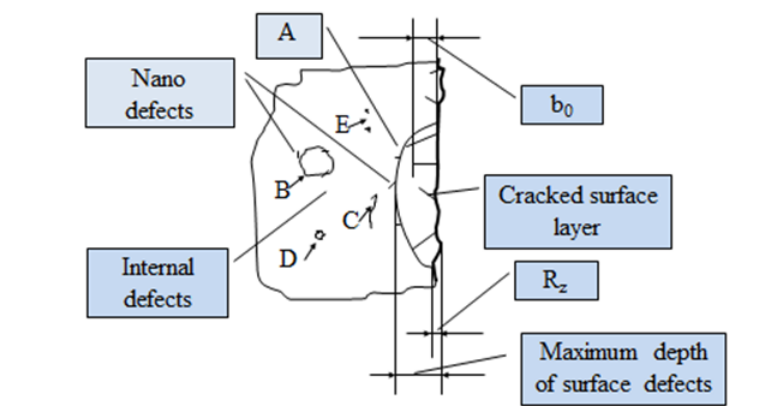
Fig.1 Surface and internal defects of glass and ceramics (b 0 – depth of initial microcracks in float glass; R z – depth of microrelief; A – maximum surface defect; B – gas bubble; D, S– micro